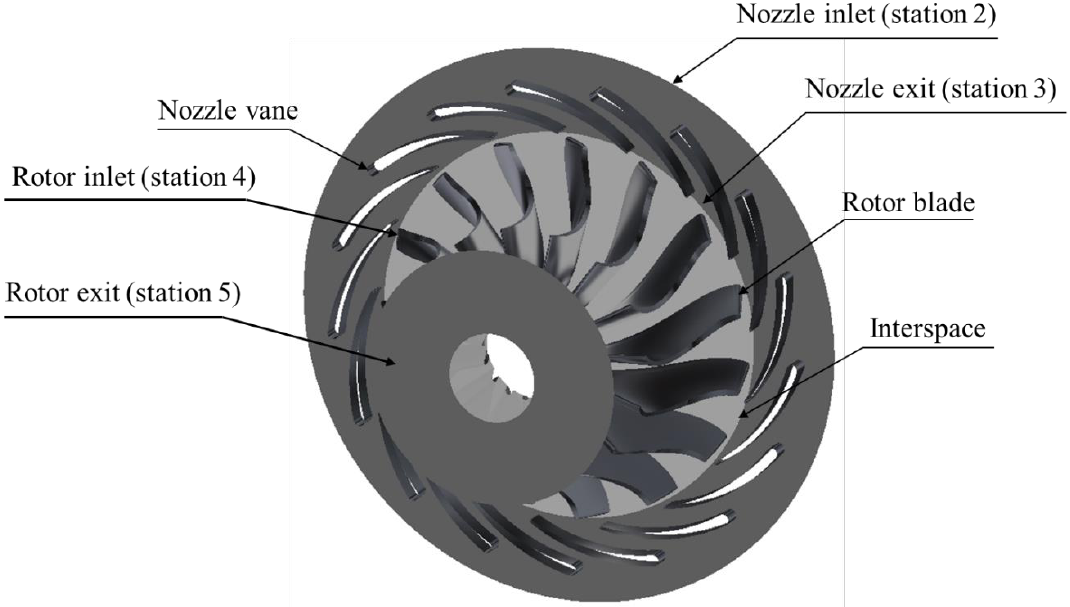
Figure 11. 3D view of a radial turbine stage and boundary conditions.